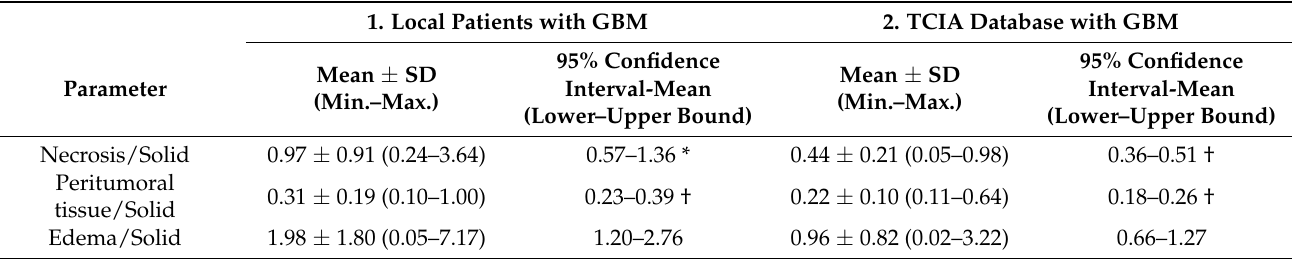
Table 2. Statistical solid tumor comparisons between local patients with GBM and TCIA database as our validation cohort to carry out a pilot study.